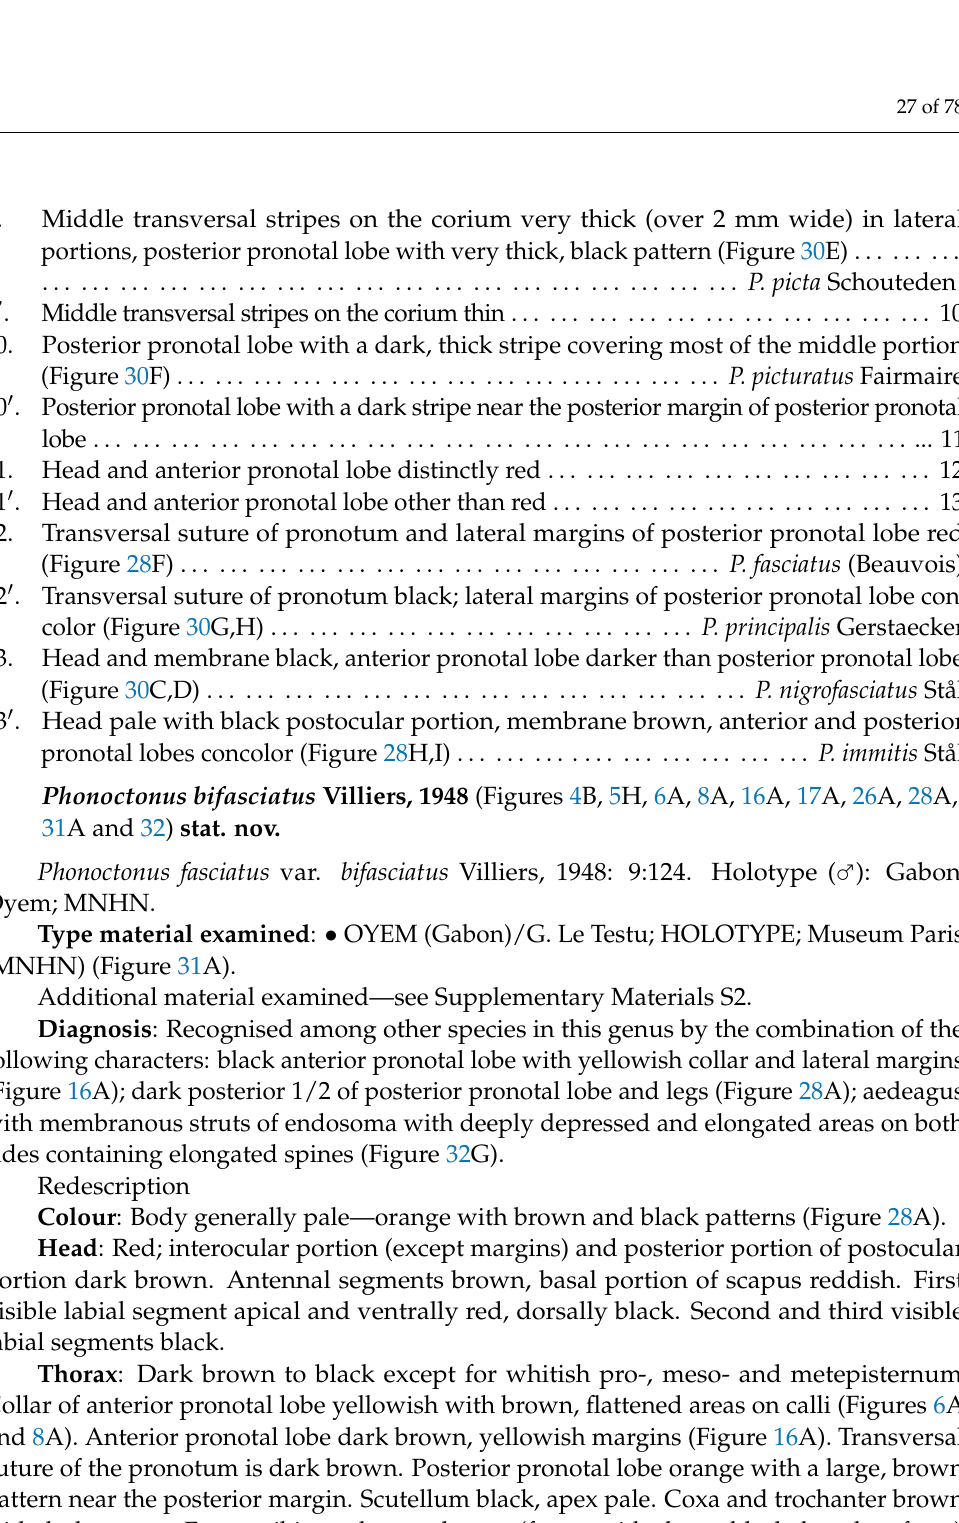
9. Middle transversal stripes on the corium very thick (over 2 mm wide) in lateral portions, posterior pronotal lobe with very thick, black pattern (Figure 30E) . . . . . . . . .